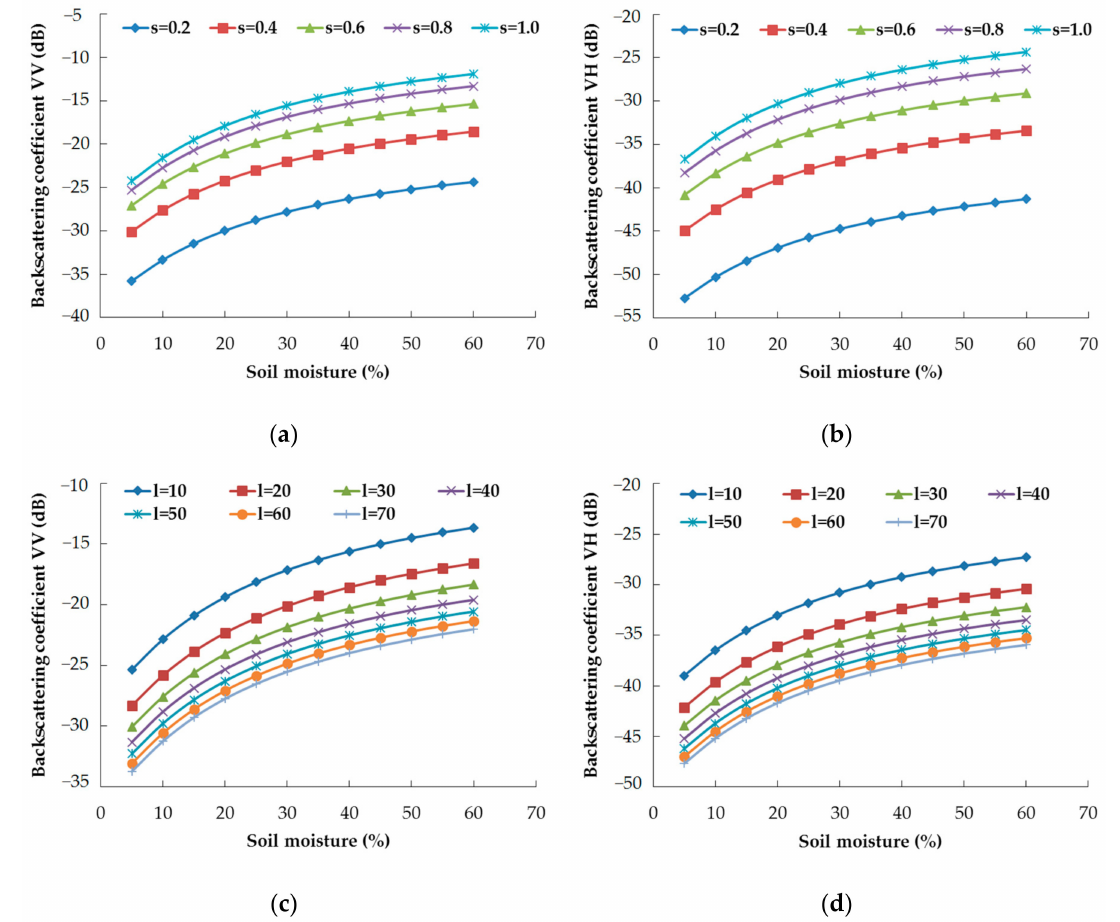
Figure 4. Responses of the backscattering coefficient and soil moisture under different roughness: ( a , b ) responses of the VV/VH under RMS heights s = 0.2, 0.4, 0.6, 0.8, and 1.0 cm when the correlation length l = 15 cm; ( c , d ) responses of the VV/VH under l = 10, 20, 30, 40, 50, 60, and 70 cm when s = 0.6